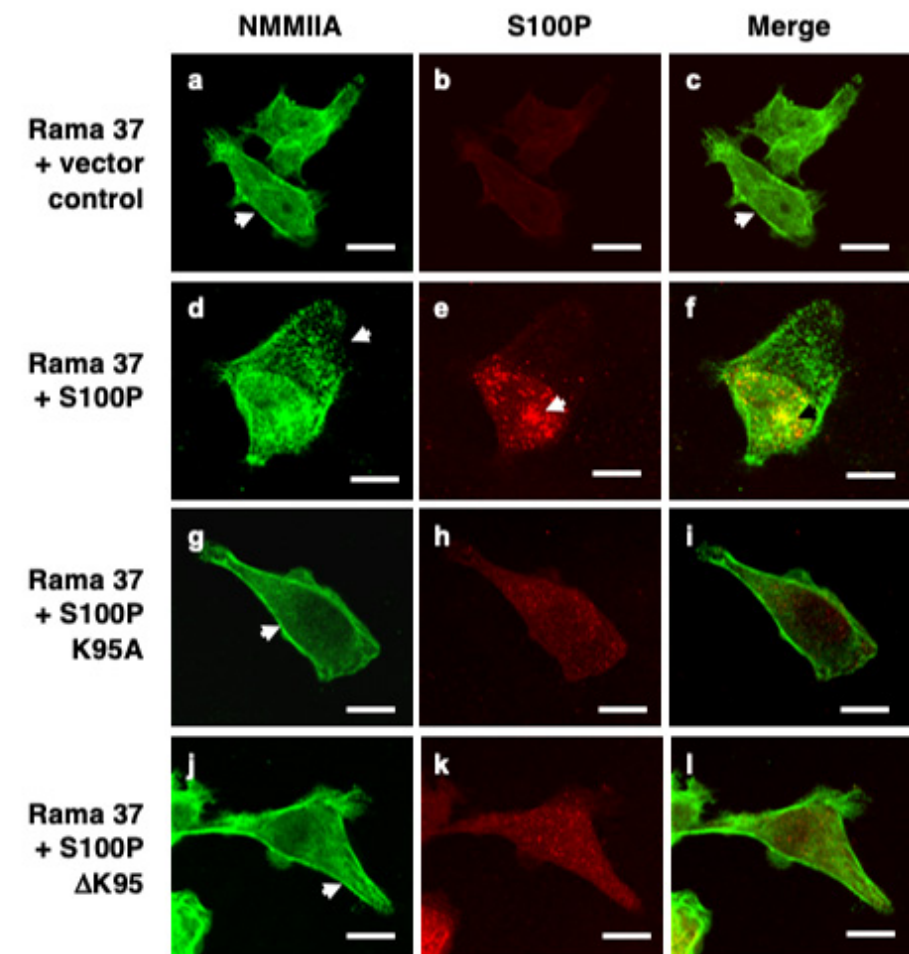
Figure 1. Immunofluorescence localisation of NMMIIA and S100P in cloned transfected cells. Rama 37 cells transfected with empty expression vector (Rama 37 + vector control; ( a – c )) or Rama 37 cells overexpressing wild-type S100P (Rama 37 + S100P; ( d – f )), K95A mutant S100P (Rama 37 + S100P K95A; ( g – i )), or ∆ K95 mutant S100P (Rama 37 + S100P ∆ K95; ( j – l )) were grown on fibronectin-coated coverslips for 48 h prior to fixation, permeabilisation, and staining using secondary antibody coupled to fluorescein isothiocyanate for NMMIIA ( a , d , g , j ) or Cy-3 for S100P ( b , e , h , k ). Cells were then mounted and viewed using a Zeiss LSM510 confocal laser scanning microscope. Merged images ( c , f , i , l ) are shown with overlaps in yellow. Arrows in ( a , c , g , j ) show filamental structures along the edge of the cell. The arrow in ( d ) shows foci of NMMIIA staining near the leading edge of the cell, which did not co-localise with S100P ( f ). The arrows in ( e , f ) show a large focus of S100P co-staining with NMMIIA in the perinuclear region. Bars, 10 µ m in all